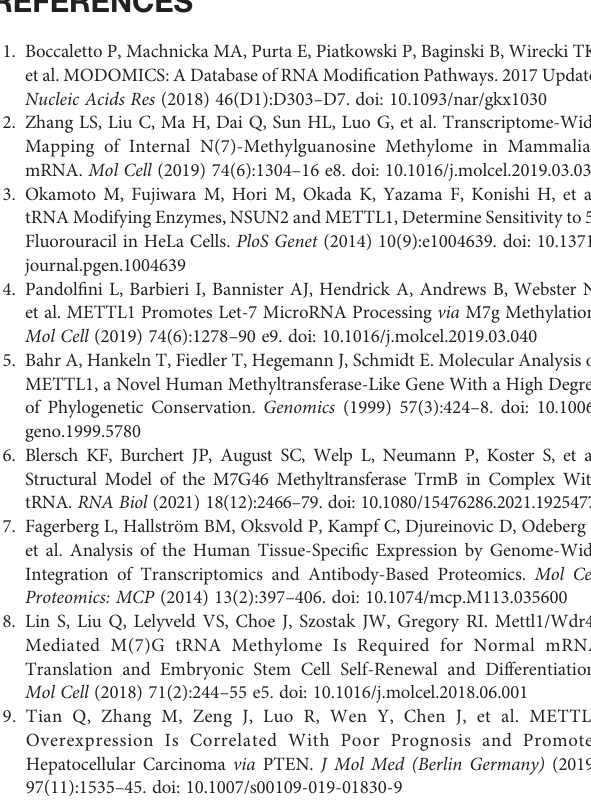
Supplementary Figure S3 | ROC curve showing sensitivity of METTL1 as a marker to predict prognosis in pan-cancer. Supplementary Figure S4 | Univariate Cox regression analyses for METTL1 activity in pan-cancer. Forest plot visualizing the association of METTL1 activity and OS, DFS, DSS as well as PFS respectively among pan-cancer. HR value > 1 represents risk factor, whereas HR value < 1 represents favorable factor. Supplementary Figure S5 | (A) Transwell assay performed in U251 transfected si-METTL1#1, si-METTL1#2, vector and ov- METTL1 cells (scale bar=100 µm). (B)